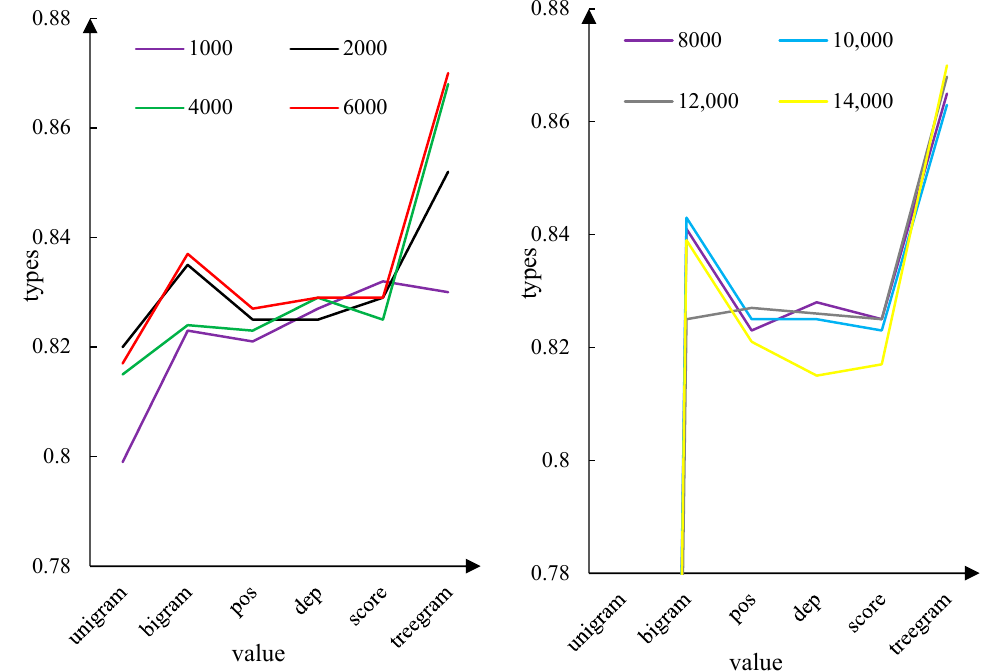
Figure 7. DBN: X600-300 classification standard rate.